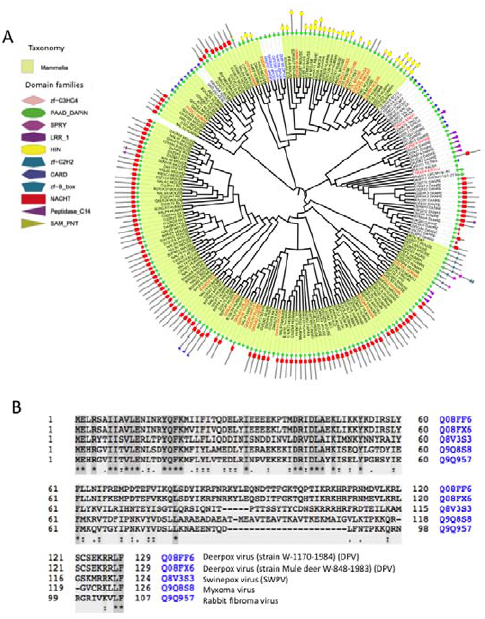
Figure 4. Analysis of the Pfam PAAD/DAPIN/Pyrin domain family. ( A ) PAAD_DAPIN (PF02758) is a diverse domain family at the N- terminal of all proteins. Visualization of the phylogenetic alignment tree is based on iTOL [56]. The Pfam family (182 proteins) includes 5 viruses from the dsDNA (Class I) that belong to Poxviridae. The viruses are shown in blue. Additional 19 proteins contain only the PAAD domain (red color). Each protein is shown as well as the schematic domain composition. Note that most proteins appear in the context of additional Pfam entries (158/177 occurrences). The length of proteins and the corresponding domains are indicated by their colored symbols in the outer circle. The mammalian proteins are highlighted. ( B ) MSA of the viral proteins covering the , 80 amino acids of the PAAD domain indicating the high divergence among these viral proteins. Similarity level is shown in a gradient of gray